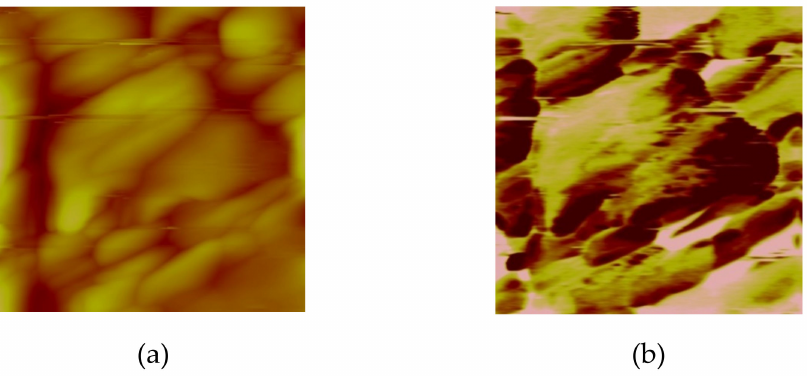
Figure 1. ( a ) Topography and ( b ) piezoresponse force microscopy image (amplitude) of BTO + 5Mn ceramics demonstrating inhomogeneous polarization distribution. The image size is 5 × 5 µ m 2